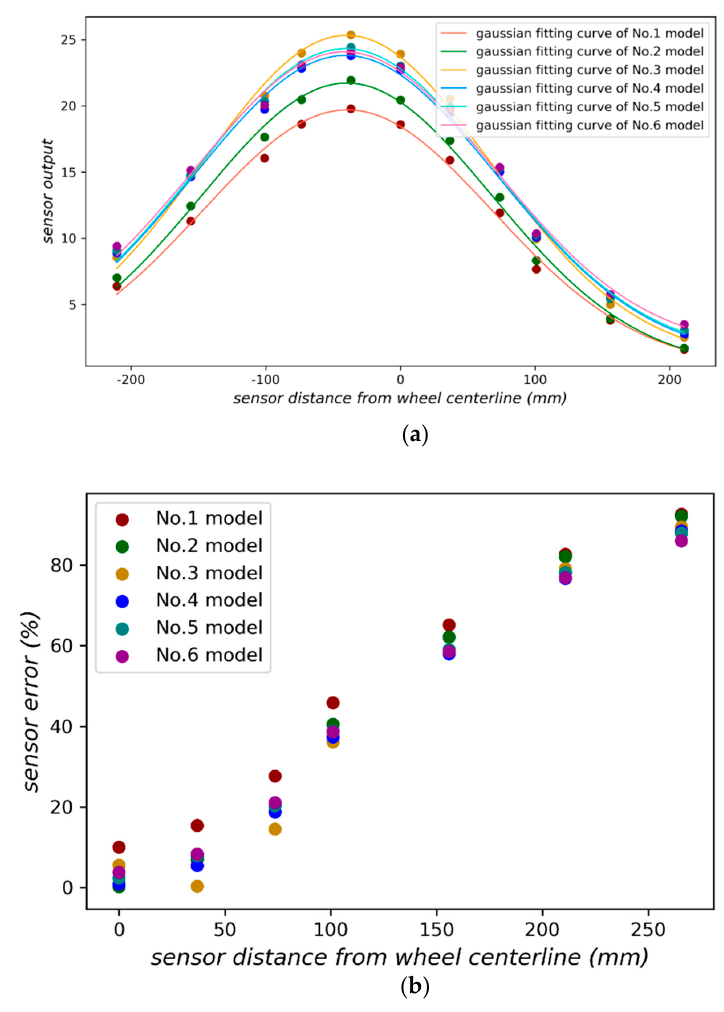
Figure 19. ( a ) Gaussian fitting curves for the placement in Figure 17; ( b ) Sensor position offset and weighing error.